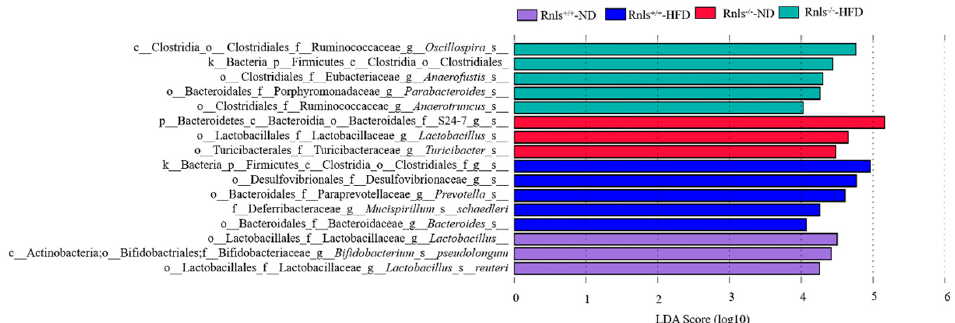
Figure 6. Significant difference in species in each group displayed using LDA scores. The distribution of LDA scores across species, with the X-axis representing LDA scores (Log10) and the Y-axis representing significantly different fecal bacterial species (LDA score > 4). Rnls –/– -ND, renalase gene knockout mice fed with normal diet; Rnls +/+ -ND, wild-type mice fed with normal diet; Rnls –/– -HFD, renalase gene knockout mice fed with high-fat diet; Rnls +/+ -HFD, wild-type mice fed with high-fat diet; LDA, linear discriminant analysis.